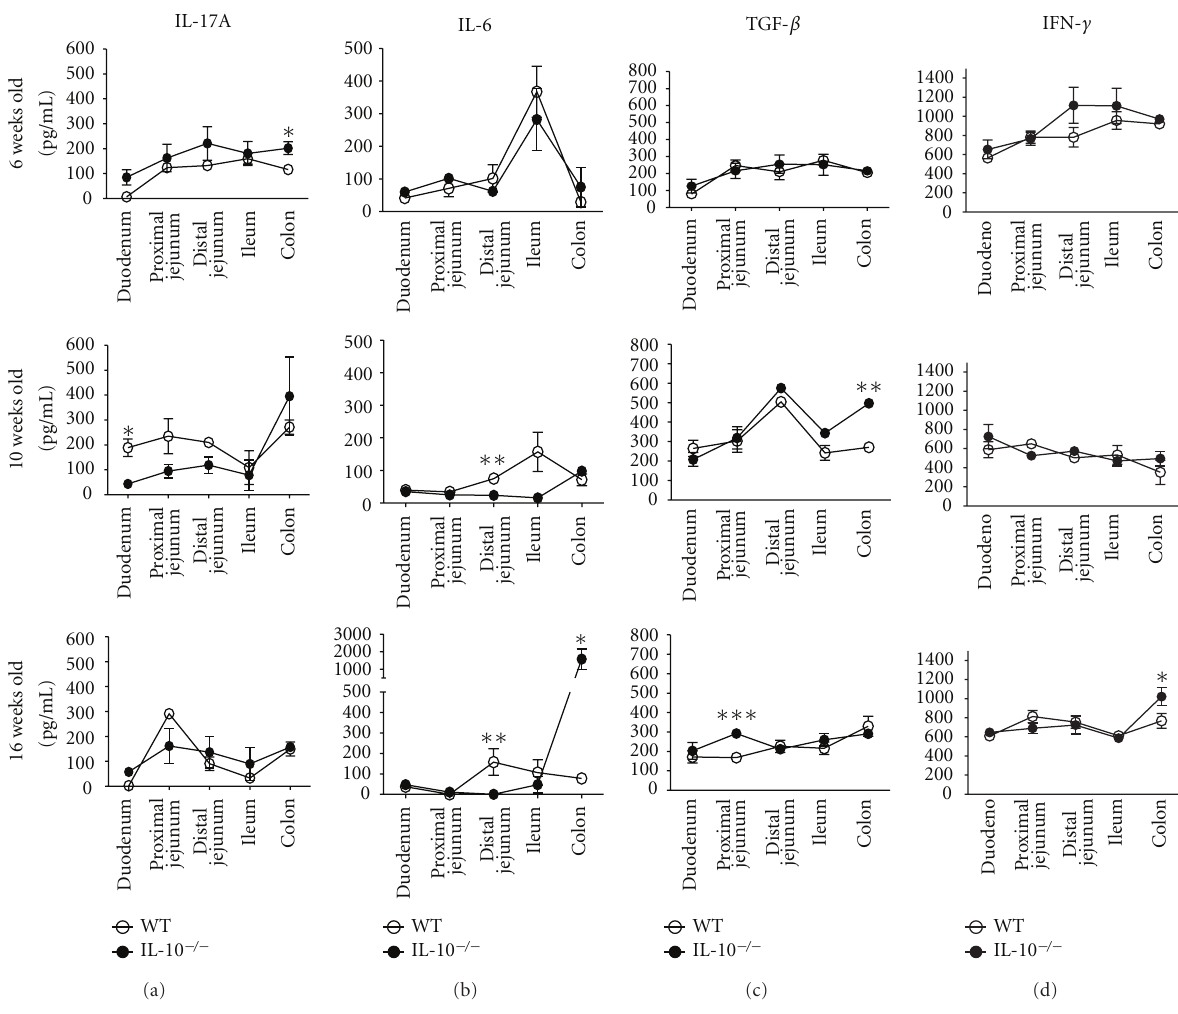
Figure 4: Production of cytokines in the intestinal mucosa during the course of intestinal inflammation. Intestines from IL-10 − / − at 6, 10 or 16 weeks of age were removed, separated into duodenum, proximal jejunum, distal jejunum, ileum and homogenized in extract bu ff er. Age-matched 129Sv/Ev (WT) mice were used as controls. Extract supernatant was collected for cytokine assay. IL-17A (a), IL-6 (b), TGF- β (c), and IFN- γ (d) were measured by ELISA. n = 5 mice per group. Asterisks represent di ff erences among groups in the same intestinal segment ( ∗ P < 0 . 05, ∗∗ P < 0 . 01 or ∗∗∗ P < 0 . 001).